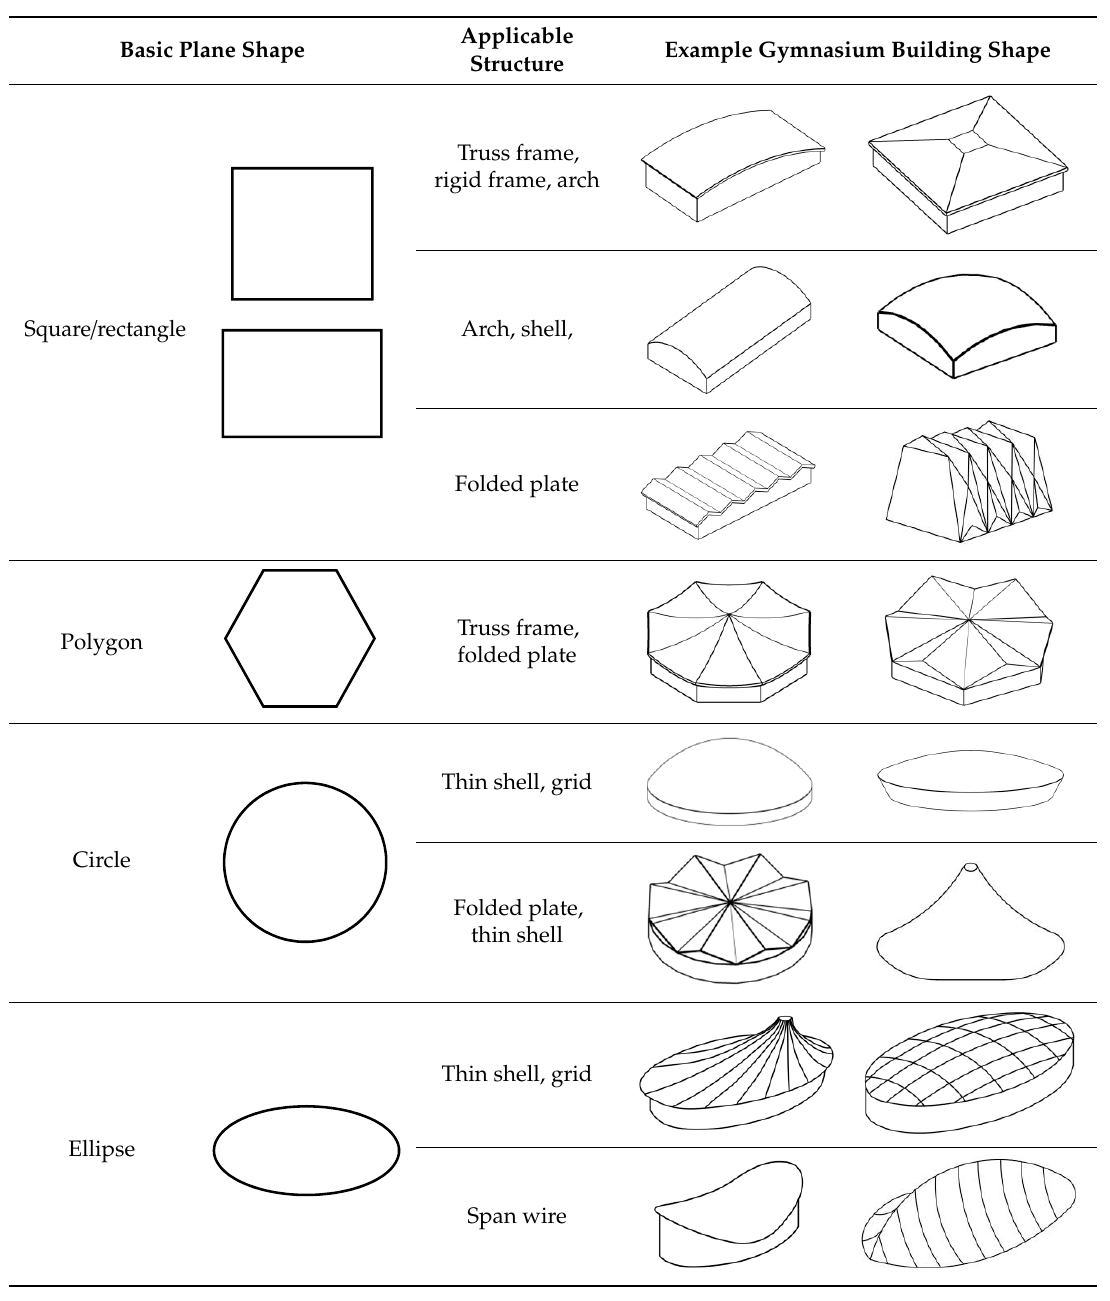
Figure 1. Various shapes of gymnasiums built around the world. ( a ) Wetland Research and Education